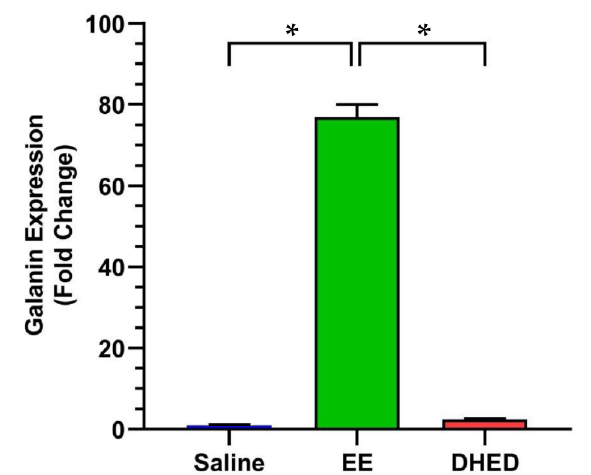
Figure 5. While EE (1 mg/kg/day b.i.d. for 13 days, p.o.) stimulated the expression of galanin in the AP of ORDX rats, DHED (300 µg/kg/day b.i.d. for 13 days, p.o.) had no statistically significant effect